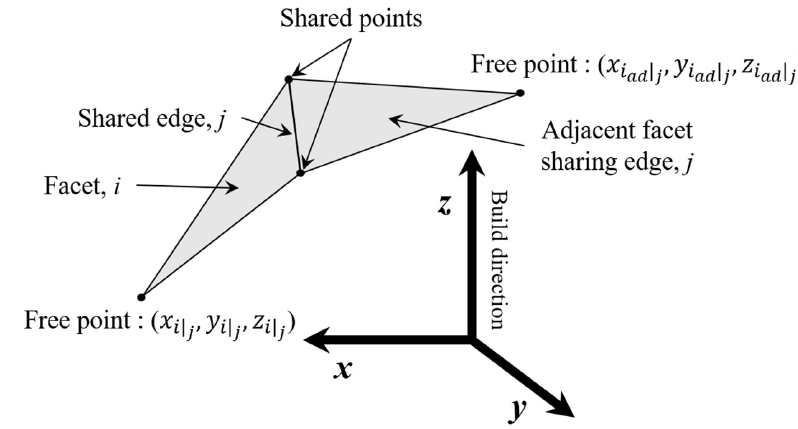
Figure 6. Geometric interconnection of a pair of facets.